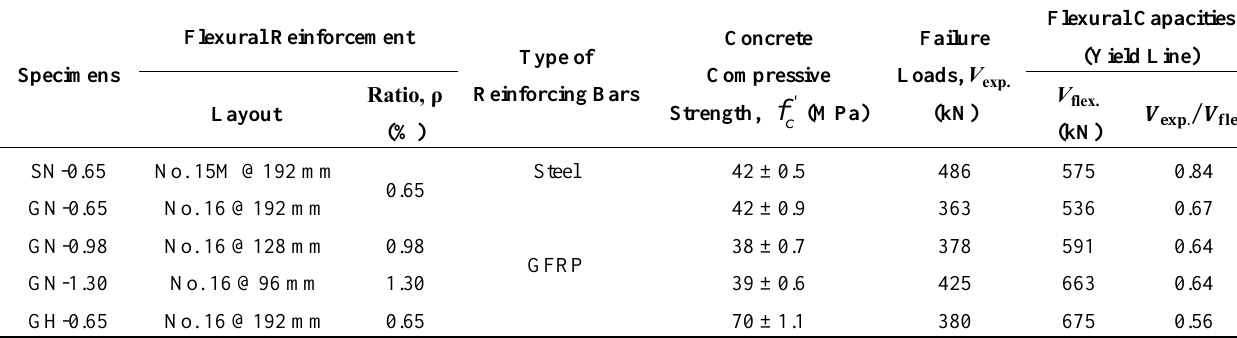
Figure 1. Details of test specimens. ( a ) Plan view; ( b ) Section A-A. All dimensions are in mm. Table 1. Details of test